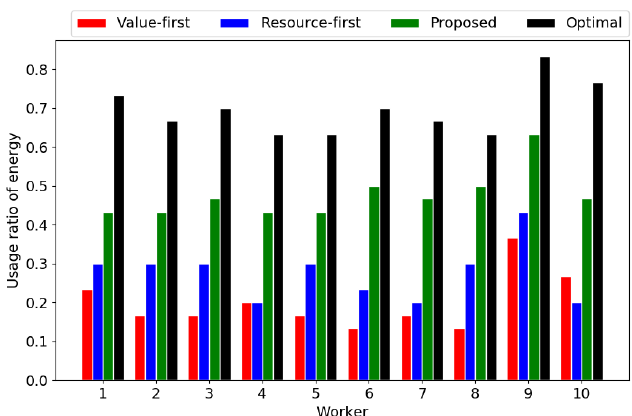
Figure 7. Usage ratio of travelling distance.